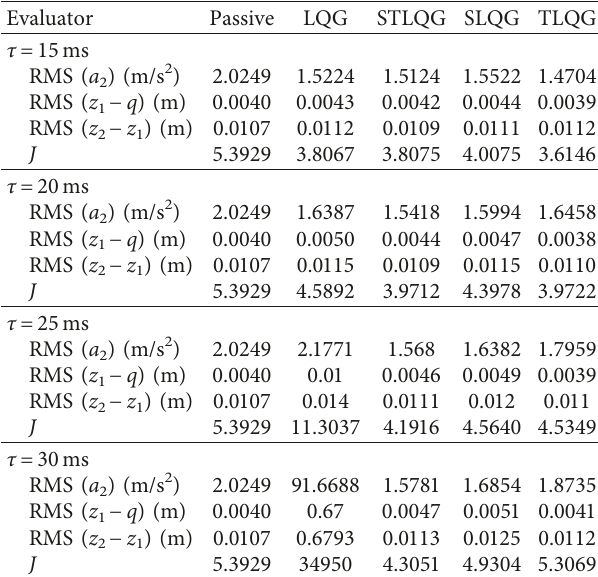
Figure 16: PSD ( a 2 )-frequency curves under 30ms time delay. Table 3: Simulation results of the passive, LQG, STLQG, SLQG, and TLQG